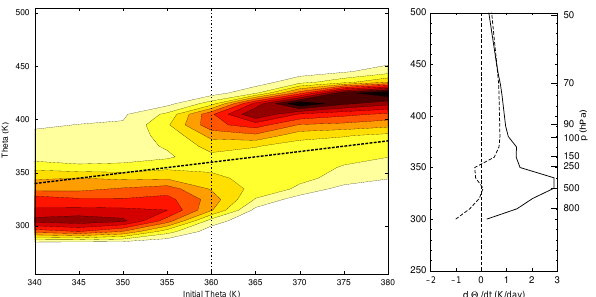
Figure 15. Left panel: distribution of diabatic trajectories in poten- tial temperature initiated between 340 to 380K ( x axis) in regions of low OLR ( ≤ 160Wm − 2 ) after 60 days. The thick black dashed line indicates the level of initialization. Right: mean JJA 2006 pro- file of d (cid:50) /d t averaged over 60–120 ◦ E and 0–30 ◦ N (solid) and over the entire tropical belt, 30 ◦ S–30 ◦ N (dashed).